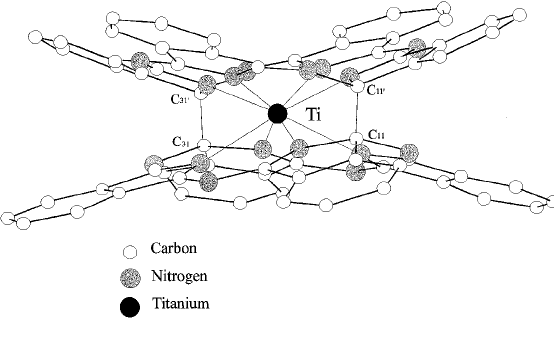
Figure 2. Side-view of titanium bis -phthalocyanine. Reproduced with the permission from reference [32].